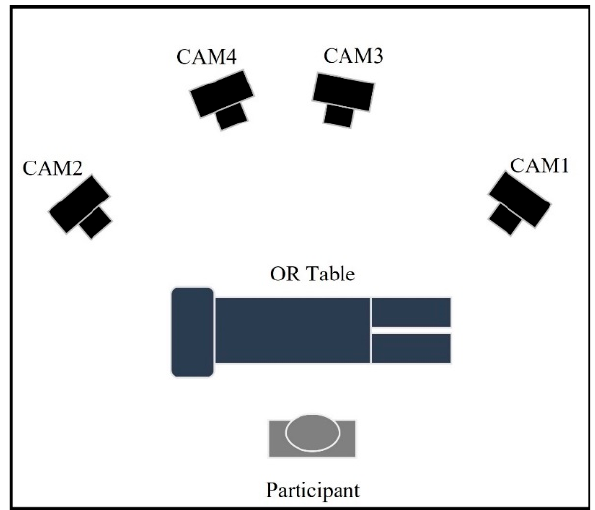
Figure 2. Schematic of Markerless-based motion capture (Top view).